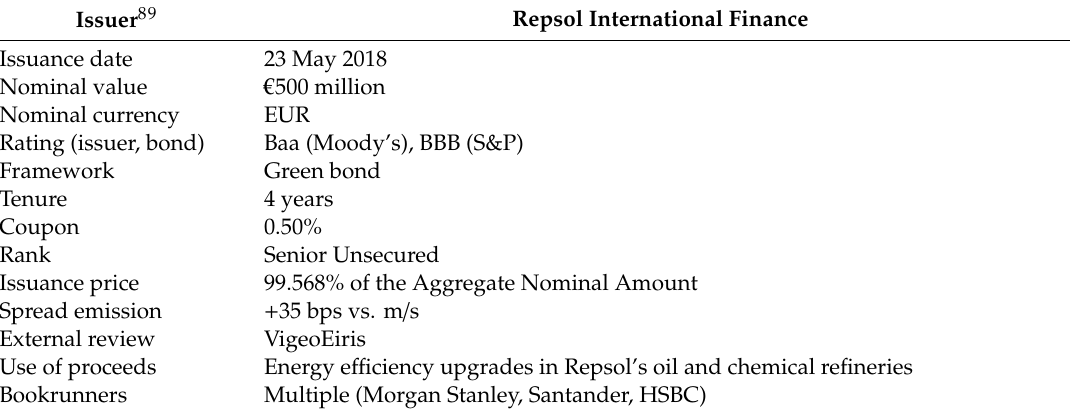
Table A4. Repsol’s green